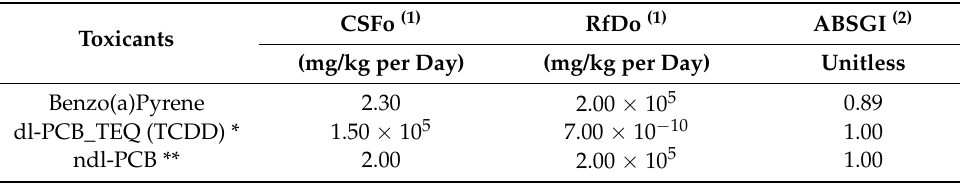
Table 2. Value of CSFo, RfDo, and ABS_GI used for potential human health risk.